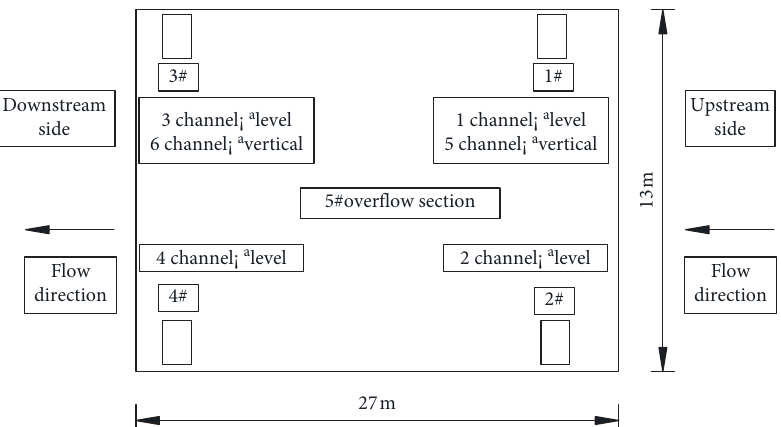
Figure 10: Measuring point layout of no. 5 overflow section of Three Gorges